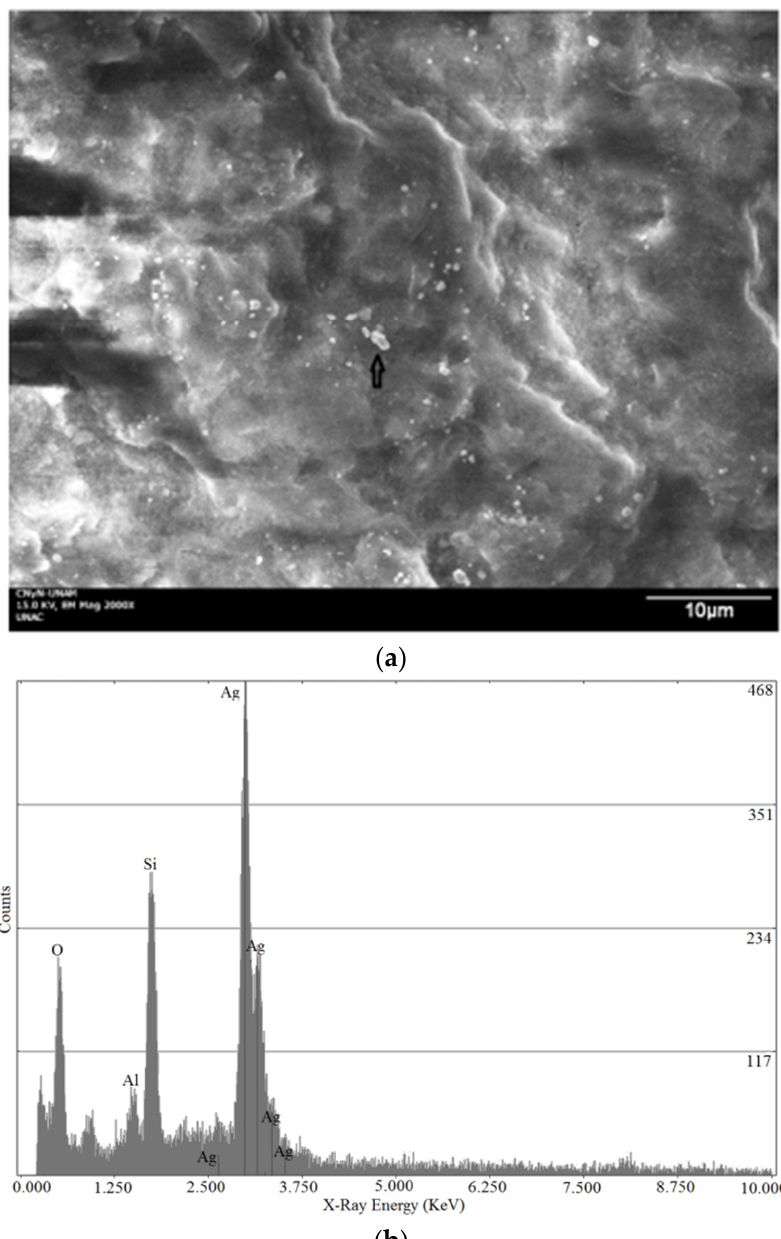
Figure 4. SEM image ( a ) of the aged bimetallic sample reduced at 450 °C (Cu3Ag1CLI Hydrot -450-A) showing the presence of silver particles on sample surface. EDS spectrum ( b ) of a silver particle (indicated with black arrow in ( a )) is shown too.